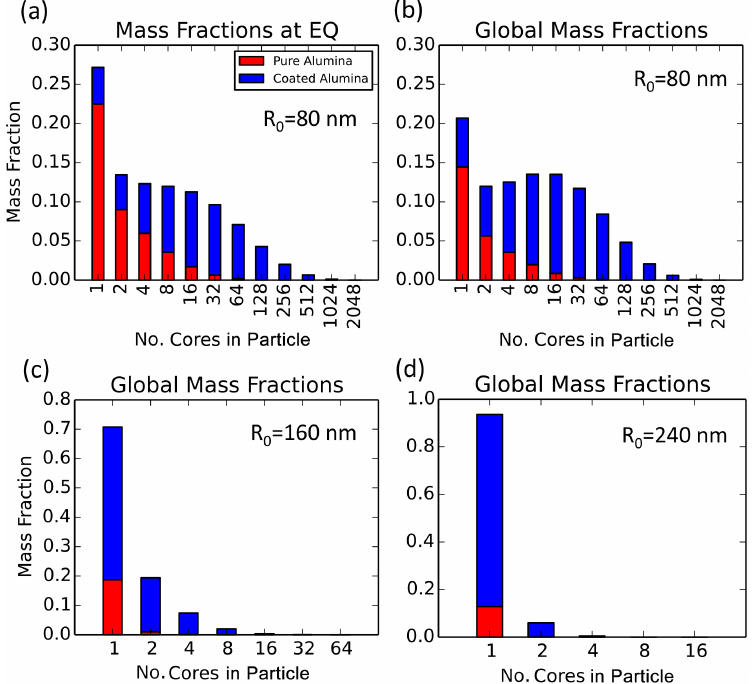
Figure 3. Distribution of integrated stratospheric alumina mass into monomers and fractals for geoengineering injection of 1Tgyr − 1 of alumina as 80nm monomers at (a) the equator and (b) , globally integrated, and for injection of 1Tgyr − 1 of alumina as (c) 160nm and (d) 240nm monomers, globally integrated. Red bar length represents the mass fraction in dry alumina and blue bar length the mass fraction in coated alumina. Annual average conditions are represented.